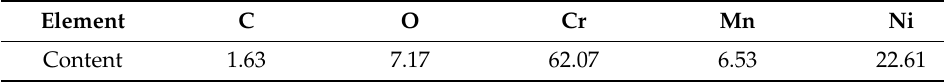
Figure 12. The corrosive surface morphology (3000 h) of all the samples without BFT. Table 5. The composition of chemical elemental in weight